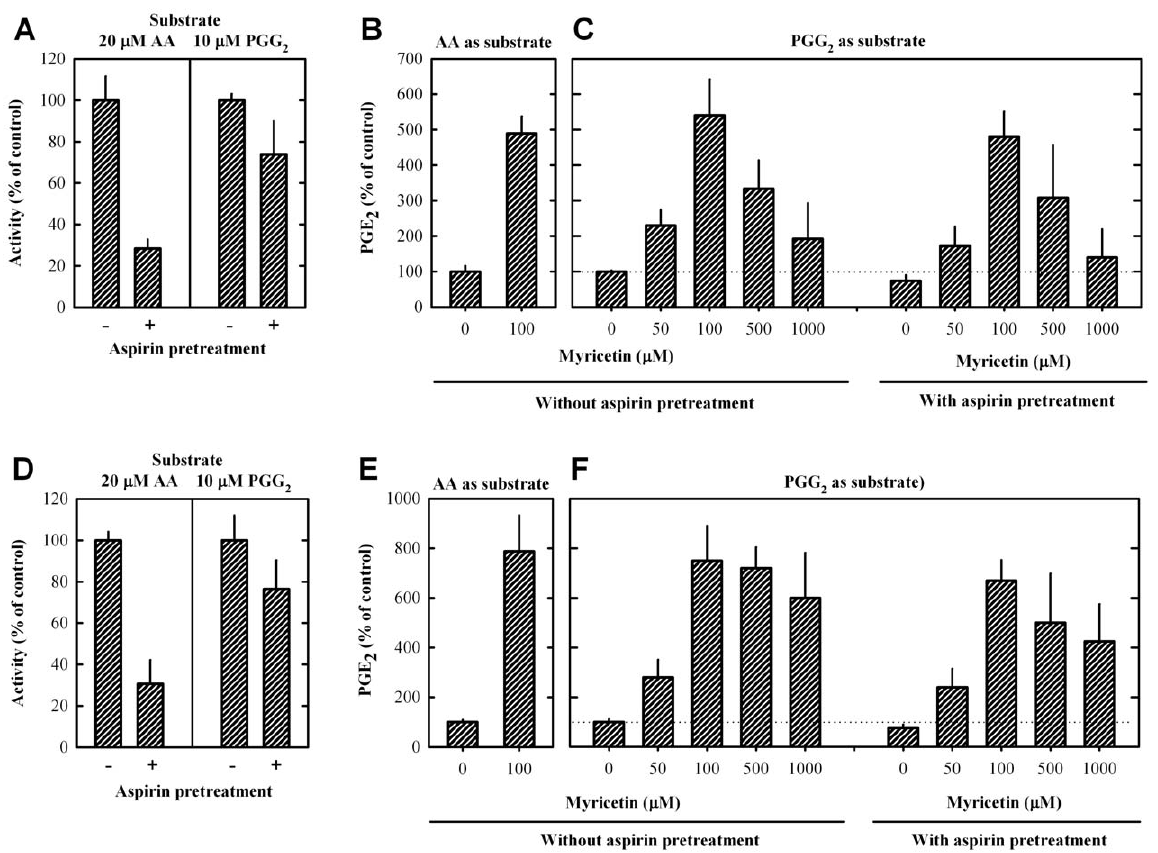
Figure 5. Myricetin stimulates the catalytic activity of COX I and II (with or without aspirin pretreatment) when [ 14 C]AA or PGG 2 is used as substrate. The incubation mixtures consisted of 20 m M [ 14 C]AA (0.2 m Ci) or 10 m M PGG 2 as substrate, COX I or COX II as enzyme (0.5 or 0.97 m g/mL, respectively), 10 mM EDTA, 1 mM reduced glutathione, 1 m M hematin, and myricetin in 200 m L Tris-HCl buffer (100 mM, pH 7.4). The reaction was incubated at 37 u C for 5 min and terminated by adding 15 m L of 0.5 N HCl to each test tube. Ethyl acetate (600 m L) was added